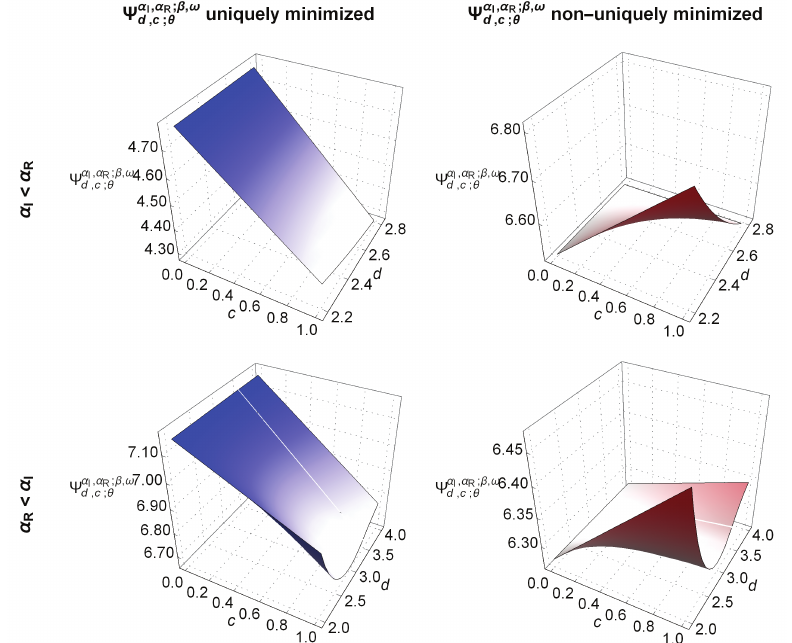
Figure 7. The surfaces of the objective function Ψ α I , α R ; β , ω are determined when α I (=0.05) < α R ( =0.07 ) (on the upper side) and when α R ( =0.03 ) < α I ( =0.05 ) (on the lower side). On the left side, Ψ α I , α R ; β , ω right side non-uniquely attains its